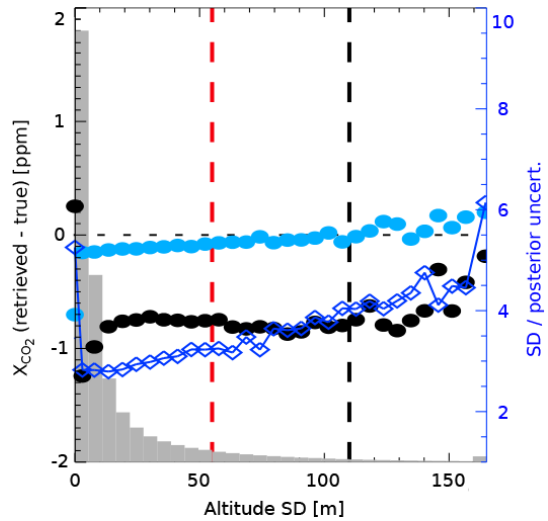
Figure 11. Difference between v9 X CO and the multi-model me- 2 dian data set over land (nadir and glint) as a function of the standard deviation of the surface elevation in the FOV given in m. The mean bias, aggregated into 10m bins, is shown for both raw (black cir- cles) and bias-corrected (light blue circles) X CO (corresponding y 2 axis on the left). The standard deviation of the bias-corrected X CO 2 difference is marked by dark blue diamonds (corresponding y axis on the right). The distribution of the standard deviation of the sur- face elevation for the time period September 2014–March 2017 is shown in gray. The vertical dashed black line represents the v9 up- per filter limit. The vertical red line represents the upper limit used in v8.